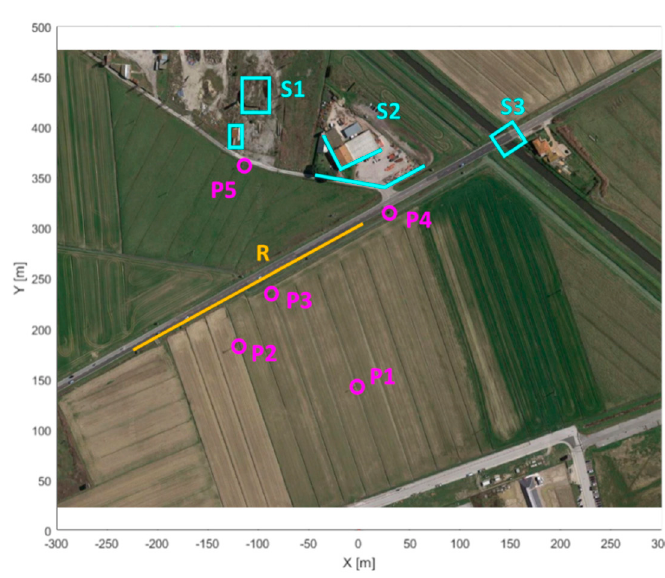
Figure 11. Acquisition scenario, top view.